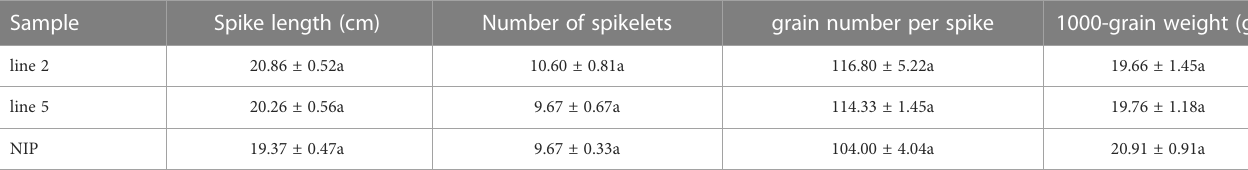
TABLE 1 Agronomic traits of the knock-out mutants of OsV-ATPase d and the wild type. Sample